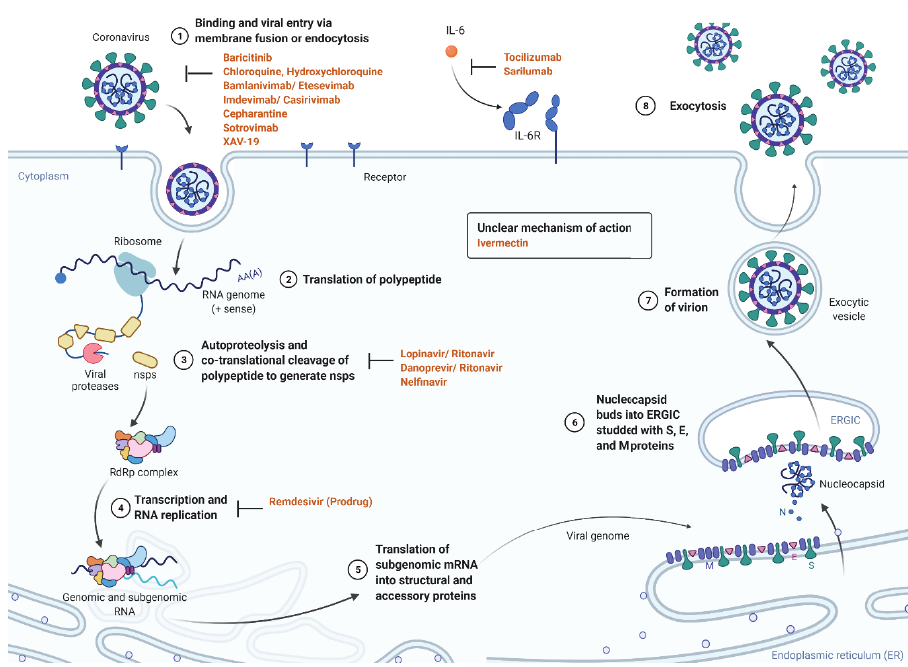
Figure 3 : Mechanisms of clinically repurposed drugs and potential therapeutic agents against SARS-CoV-2. Created with